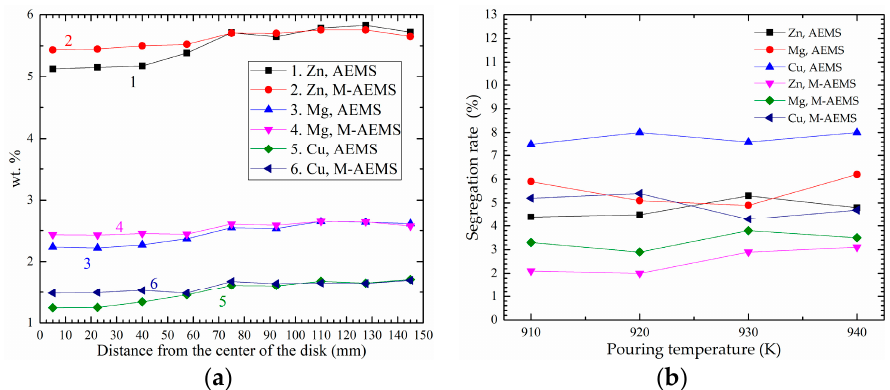
Figure 12. ( a ) The Zn, Mg and Cu elements distribution and ( b ) segregation rates with different pouring temperature in the radial direction of the disk pieces by AEMS and M-AEMS.